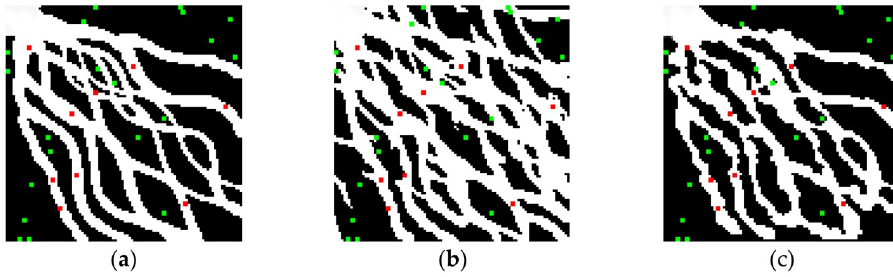
Fig 11. Stochastic realizations of the complex sedimentary model: (a) target model; (b) realization using SNESIM; (c) realization using optimized MPG facies modeling based on a DFNN.